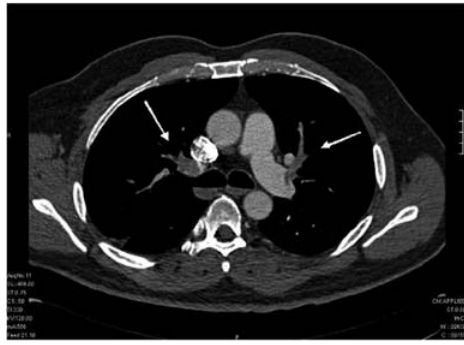
Figure 3 - Angio-CT demonstrating a massive bilateral pulmonary throm- boembolism